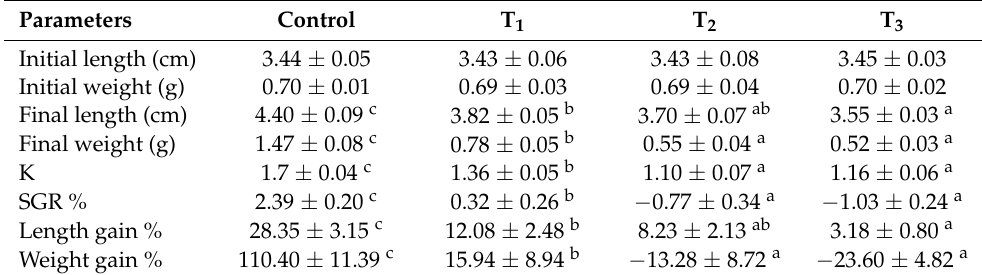
Table 4. Growth performance of O. niloticus exposed to Pb(NO 3 ) 2 at different concentrations.